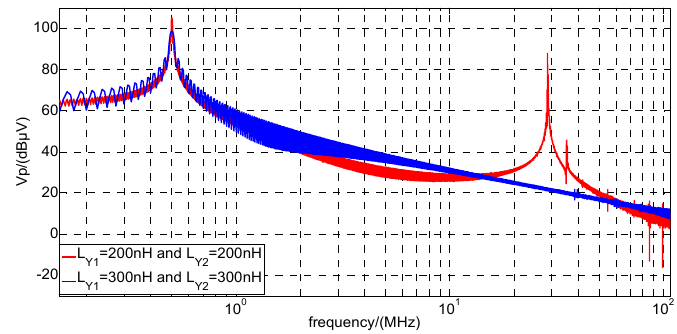
Figure 14. Positive CE voltage after L Y1 and L Y2 were increased.